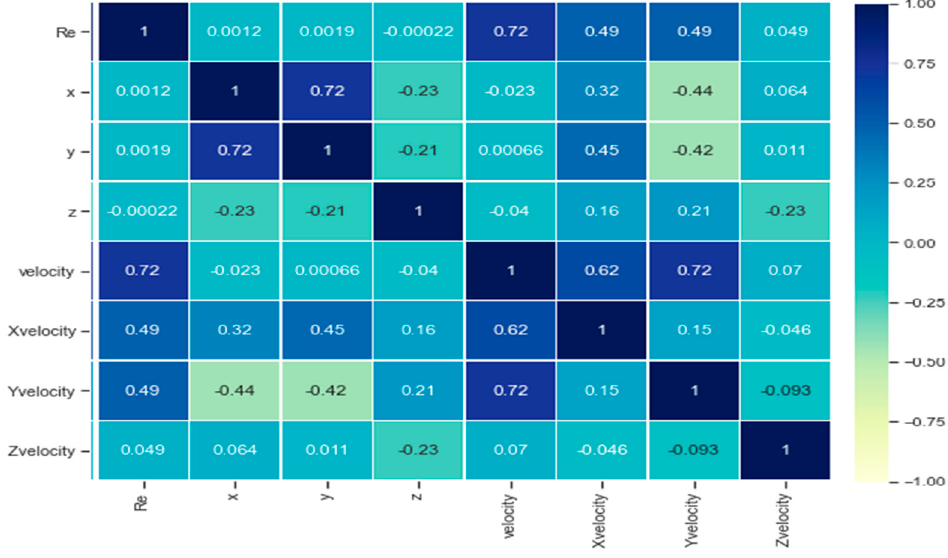
Figure 4. Correlation heat map between features and targets.